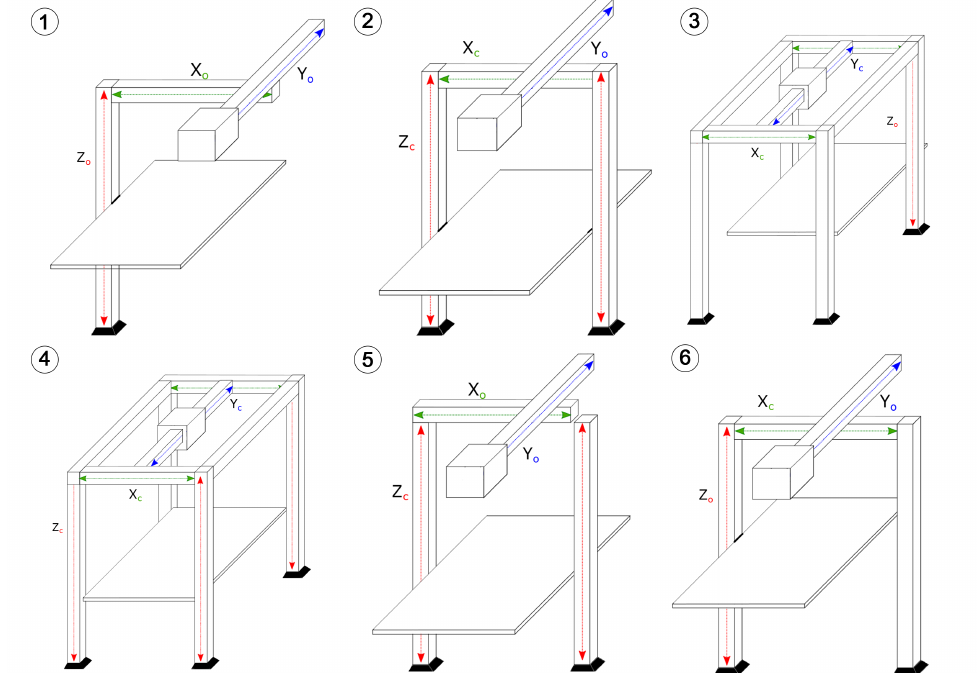
Figure A6. Fixed axes X B , Y B , Z H and actuated axes X H , Y H , Z B . Existing designs are 3 and 4.